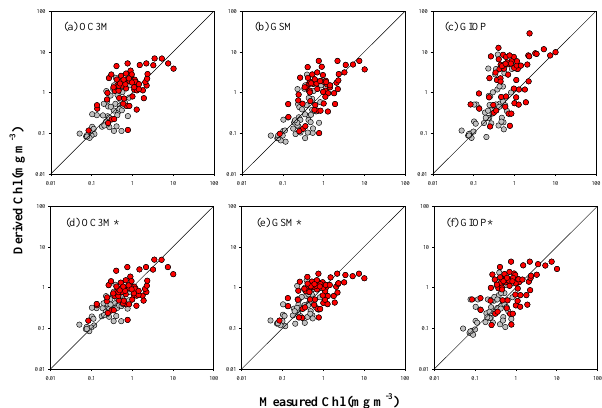
Fig. 9. Comparison between MODIS R rs derived Chl and field measured Chl where MODIS Chl was derived using three algorithms and their tuned forms: (a) OC3M; (b) GSM; (c) GIOP; (d) tuned (GIOP*). Red symbols refer to data collected from nearshore waters (depth <50m). Statistics of the algorithm performance are listed